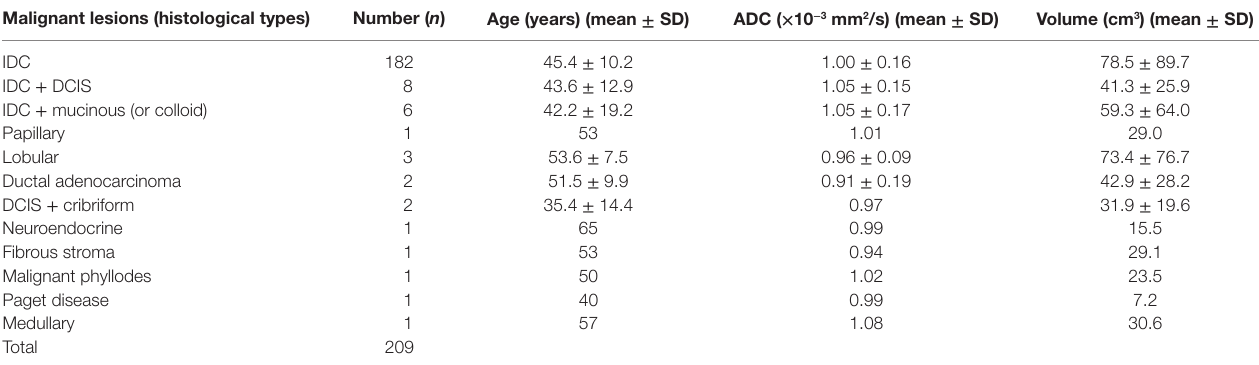
TaBle 3 | Distribution of mean aDc, volume, and age in various histological types of breast cancer patients ( n = 209). Malignant lesions (histological types)